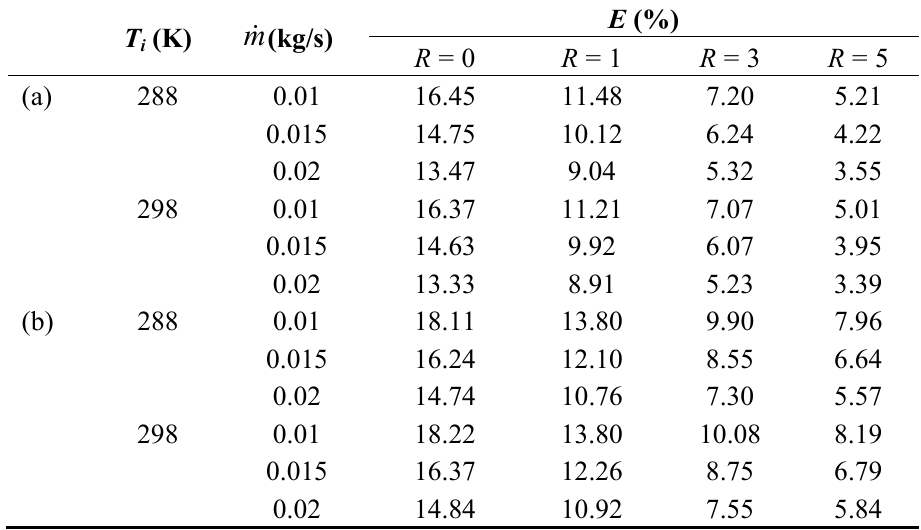
= 830 W/m 2 ; ( b ) I = 1100 W/m 2 0 0